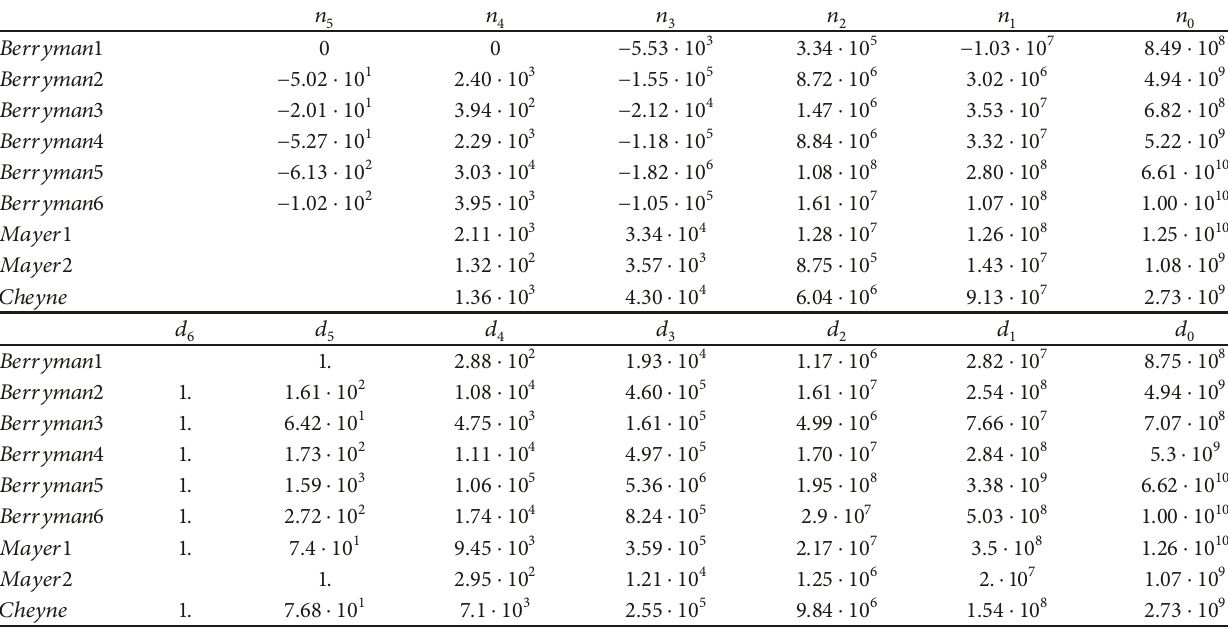
Table 2: Coefficients of collective control transfer functions identified in